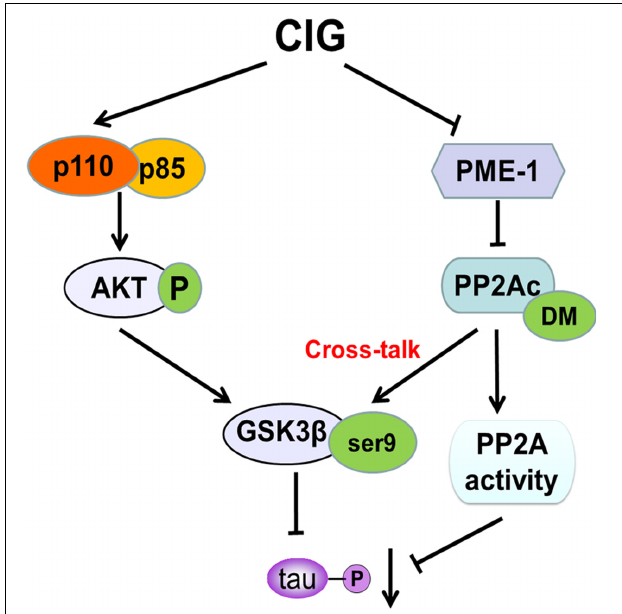
FIGURE 7 | A proposed scheme shows the mechanisms of CIG to inhibit tau